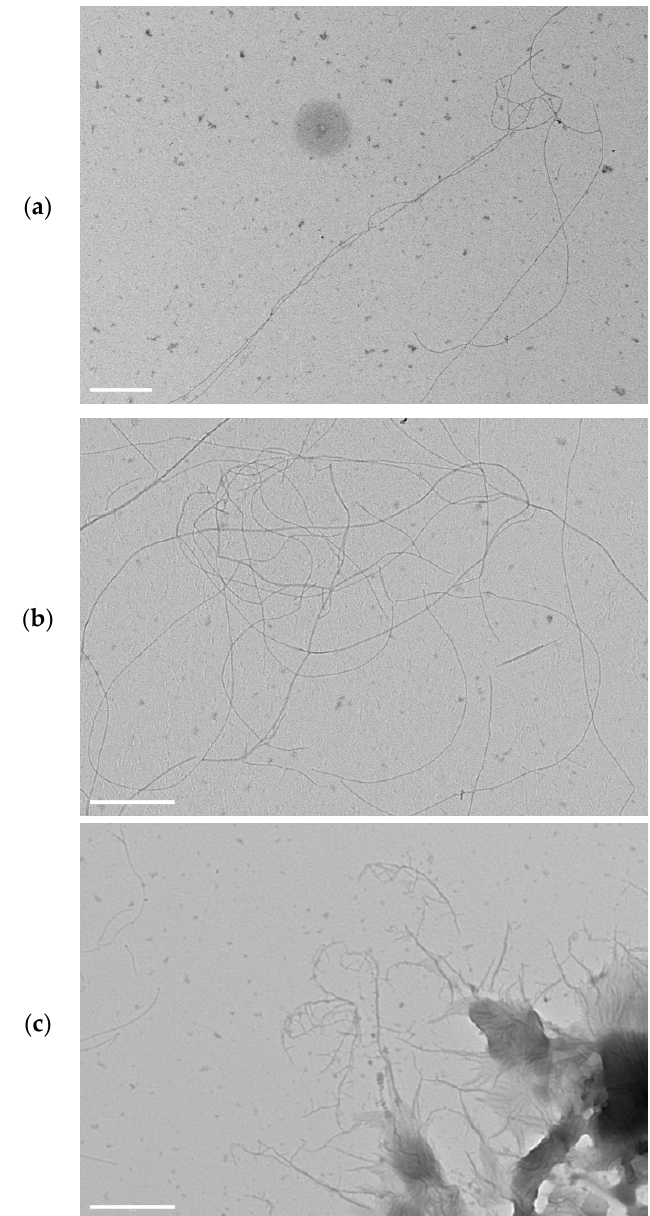
Figure 7. TEM images of diluted samples of hydrogel H4 ( a ), H5 ( b ), and H6 ( c ). Scale bar represents 500 nm.